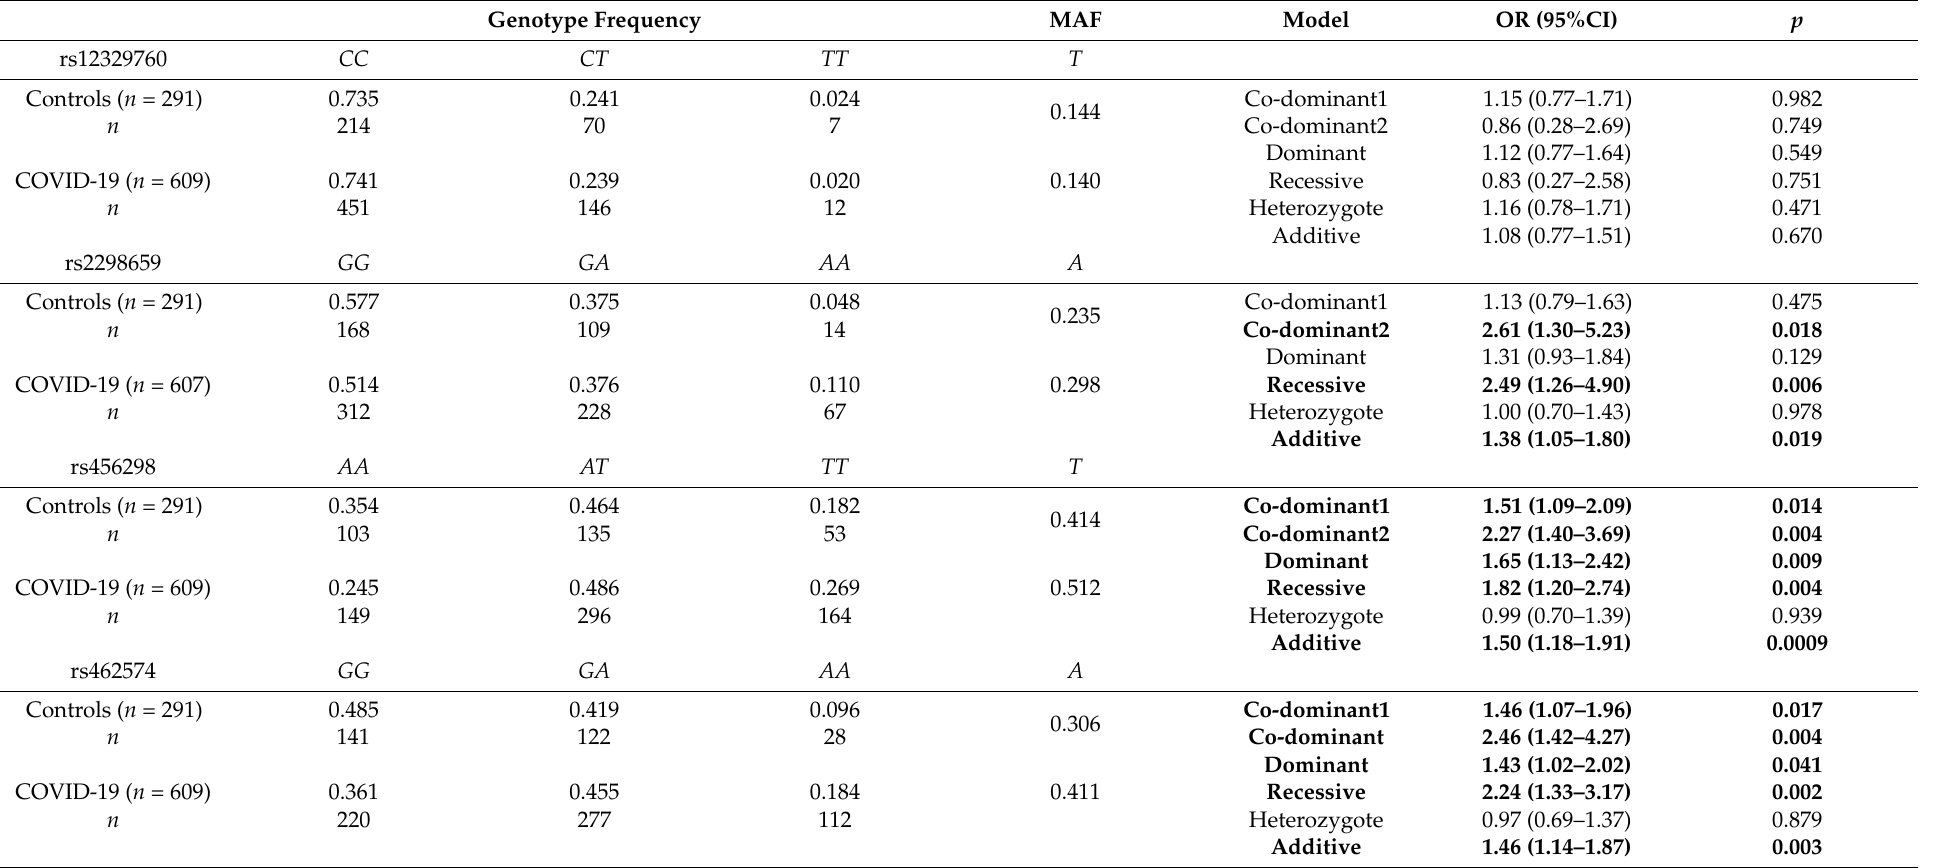
Table 2. Association of TMPRSS2 polymorphisms with